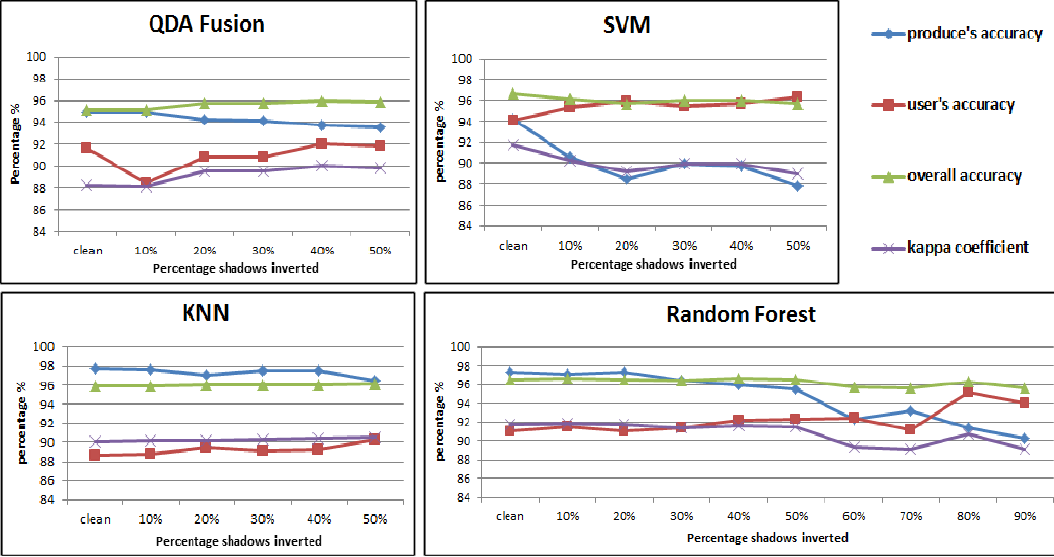
Figure 11. Results of four methods tested with six different level of mislabels. Kappa coefficient is also scaled to [1 100] to show in the same image with other